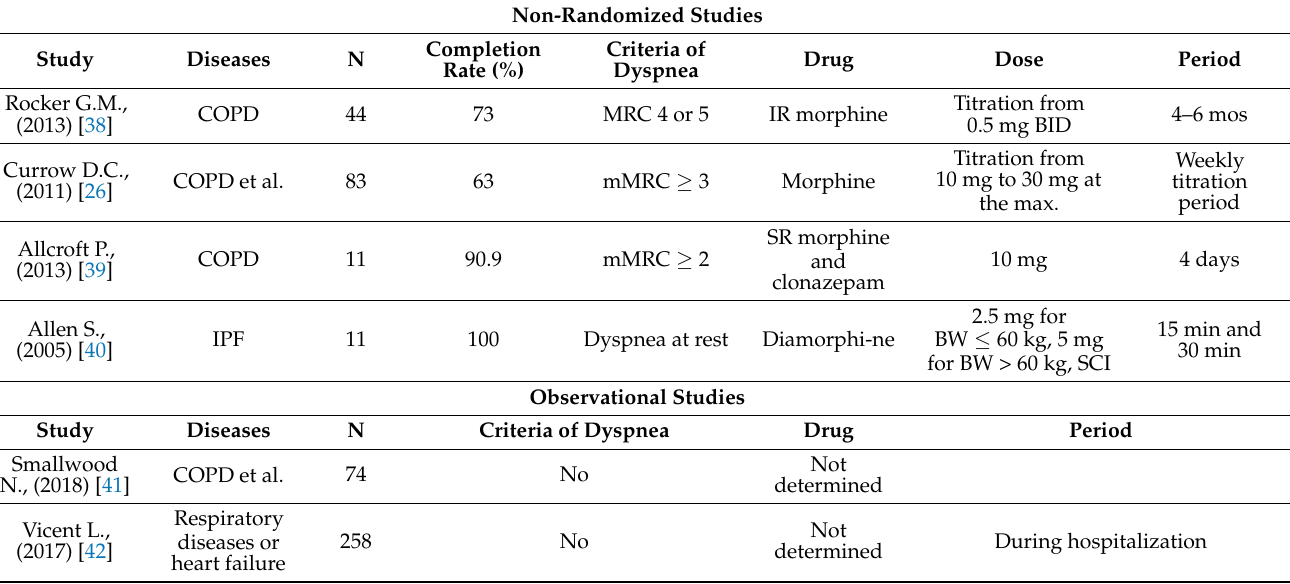
Table 4. Characteristics of non-randomized or observational studies of systemic opioids for non- cancer chronic respiratory disease.